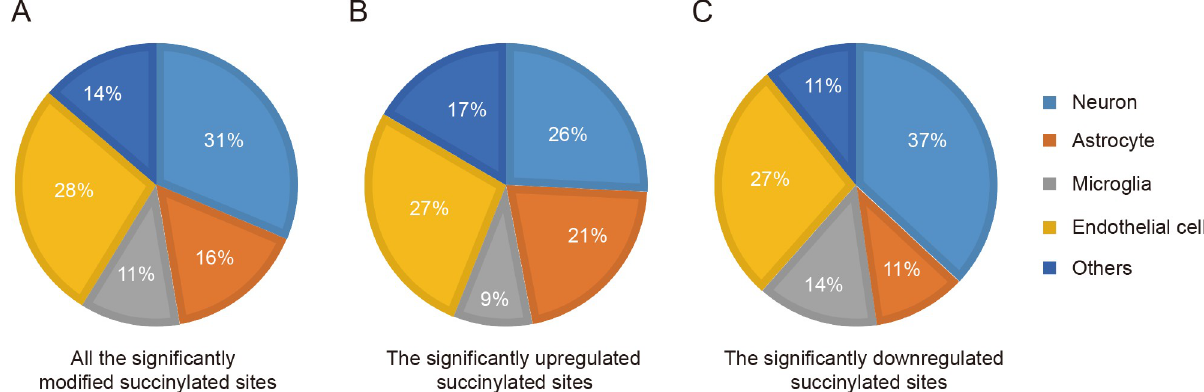
Fig 4. Combined analysis of succinylproteomics and transcriptomics data. (A-C) Pie charts showing the major cellular distribution of differentially succinylated sites (A), significantly upregulated (B), and downregulated succinylated sites (C) after ICH. Matching the significantly altered proteins (Student’s t-test, P < 0.05) with the relatively highly expressed genes of neural cells (the gene expression of the four main neural cell types was higher than that in the other cell types) from the published transcriptome data [17].